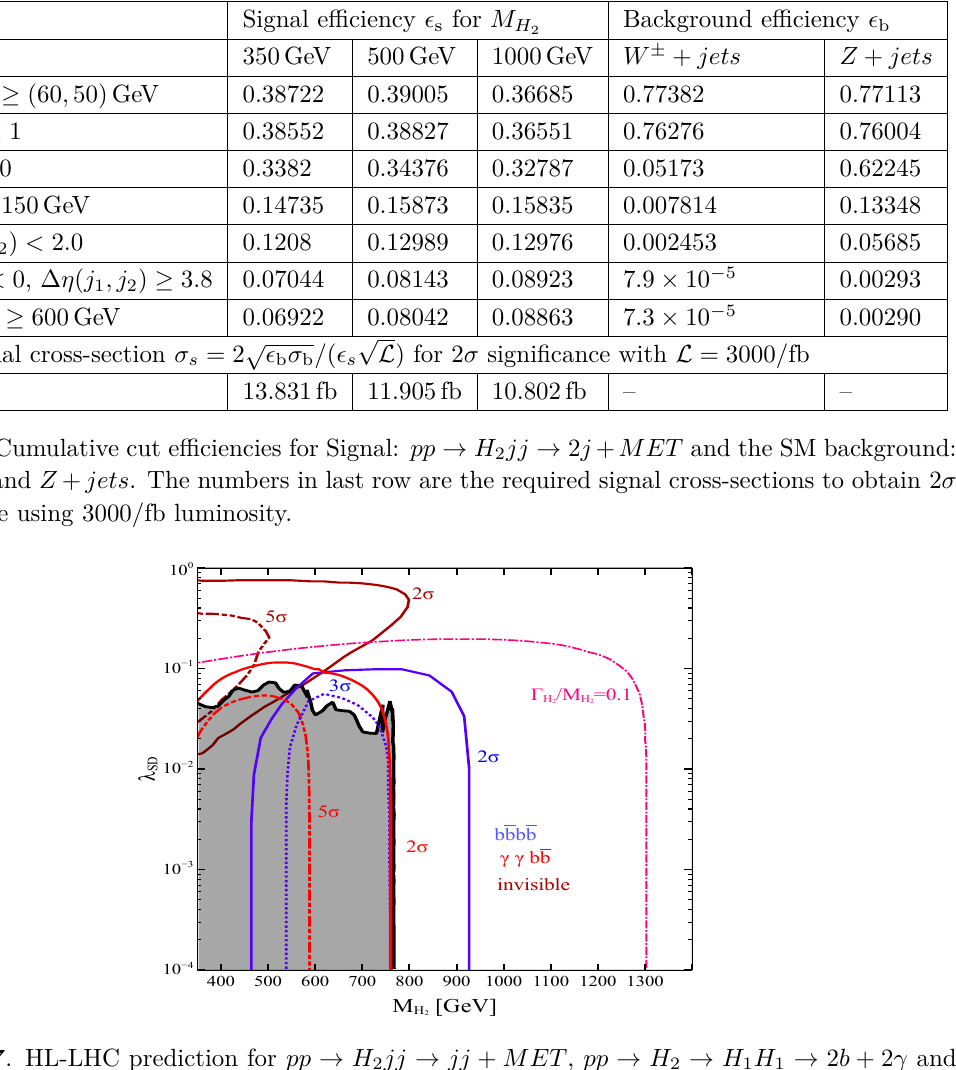
− λ SD plane. 2 [53]. See text for 2 → ZZ